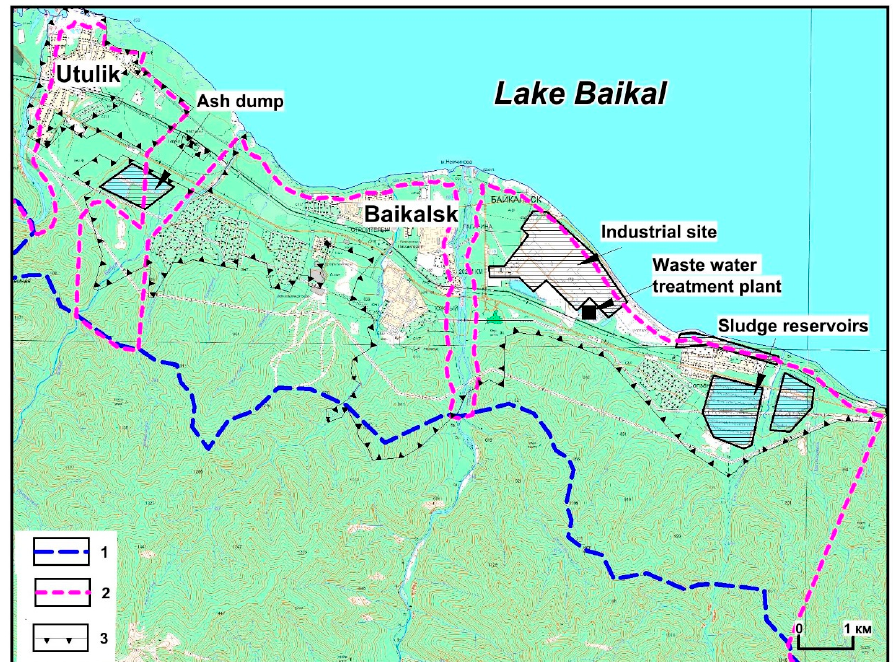
Figure 2. Boundary of the water protection zone of Lake Baikal, Baikalsk town area. 1—Science based boundary of the water protection zone, suggested by scientific organizations (with consideration of active exogenous processes in the region). 2—Water protection boundary, approved by the Government of Russia (without consideration of mudflow and avalanche threats). 3—Boundaries of residential areas.